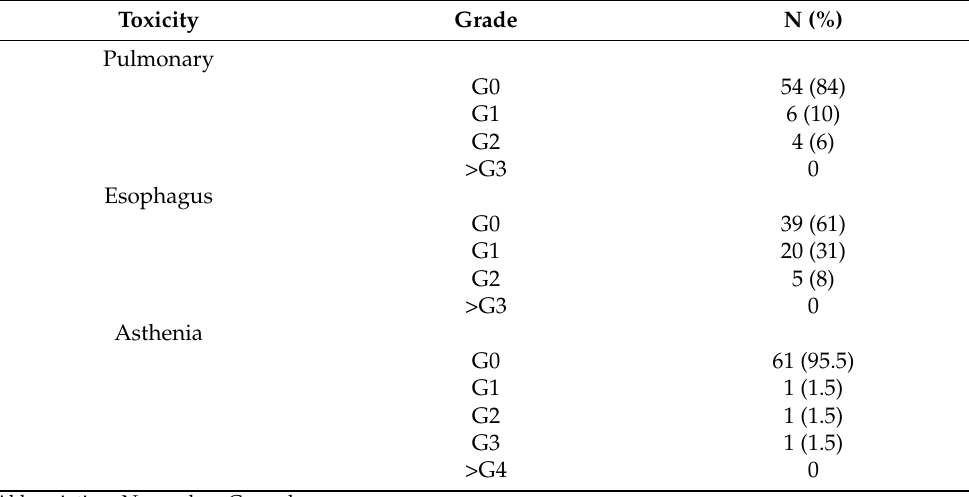
Table 2. Acute radiotherapy-related toxicity, according to CTCAE v4.0.